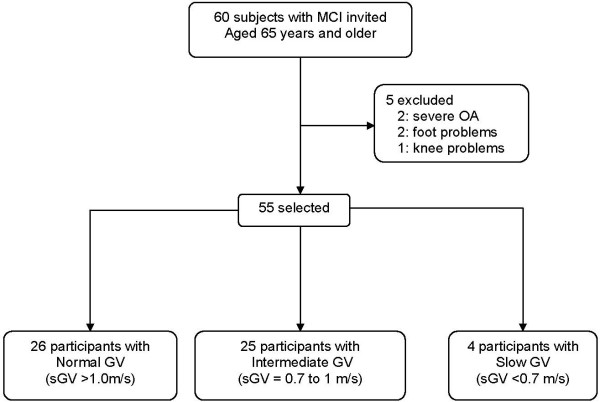
Selection of study participants. Note: MCI: mild cognitive impairment; GV: gait velocity; sGV: single task gait velocity; OA: osteoarthritis.